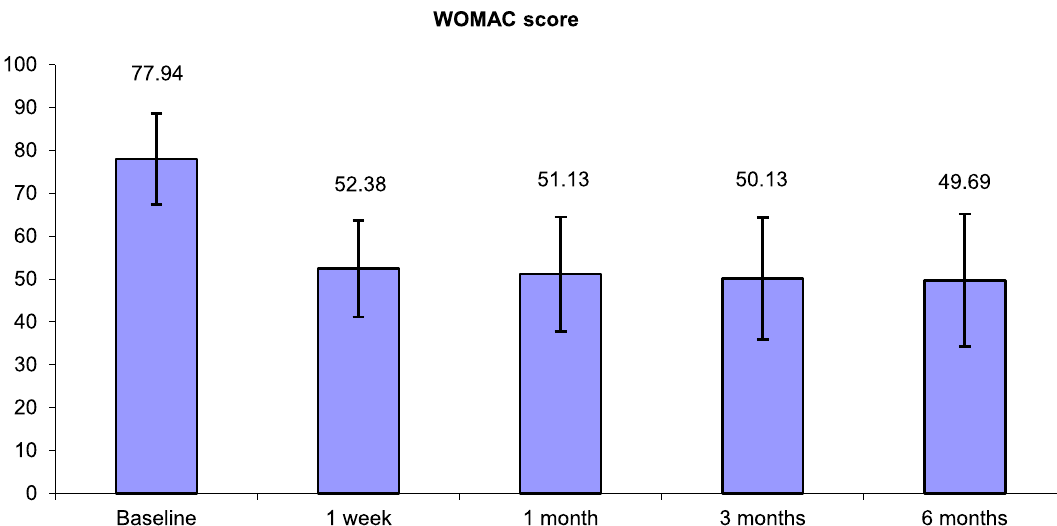
Fig. 5 The graph illustrates the relationship of WOMAC score in relation to time (baseline and at 1 week, 1, 3 and 6 months post-embolization